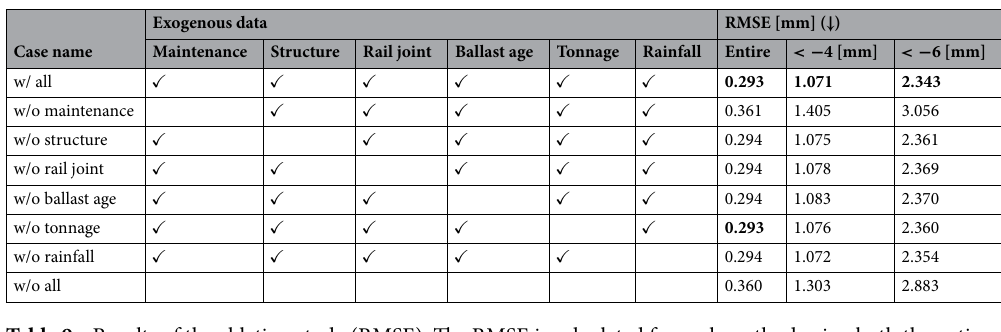
Table 9. Results of the ablation study (RMSE). The RMSE is calculated for each method using both the entire data and the data with the threshold levels α = − 4, − 6